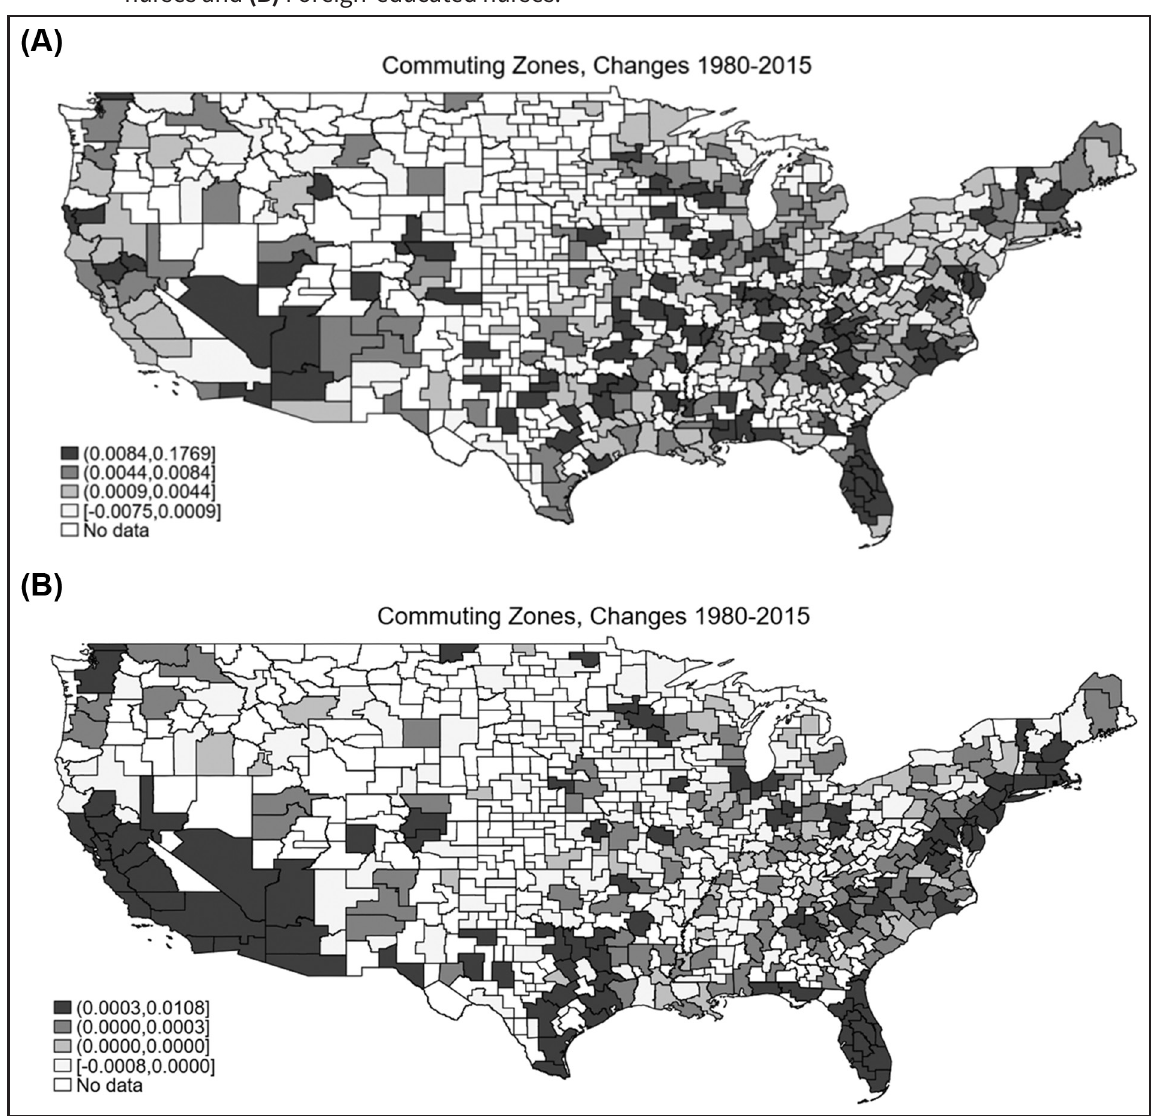
Figure 1 Changes in the number of registered nurses as a share of the initial population. (A) US-educated nurses and (B) Foreign-educated